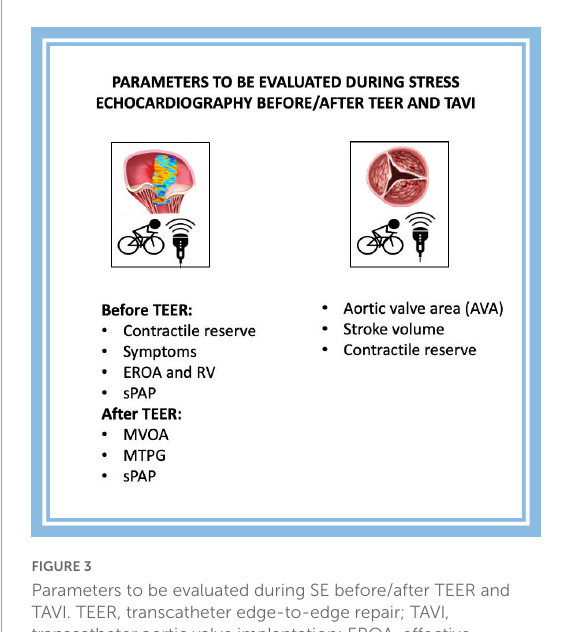
FIGURE3 Parameters to be evaluated during SE before/after TEER and TAVI. TEER, transcatheter edge-to-edge repair; TAVI, transcatheter aortic valve implantation; EROA, effective regurgitant orifice area; RV, regurgitant volume; sPAP, systolic pulmonary arterial pressure; MVOA, mitral valve opening area; MTPG, mean trans -valvular pressure